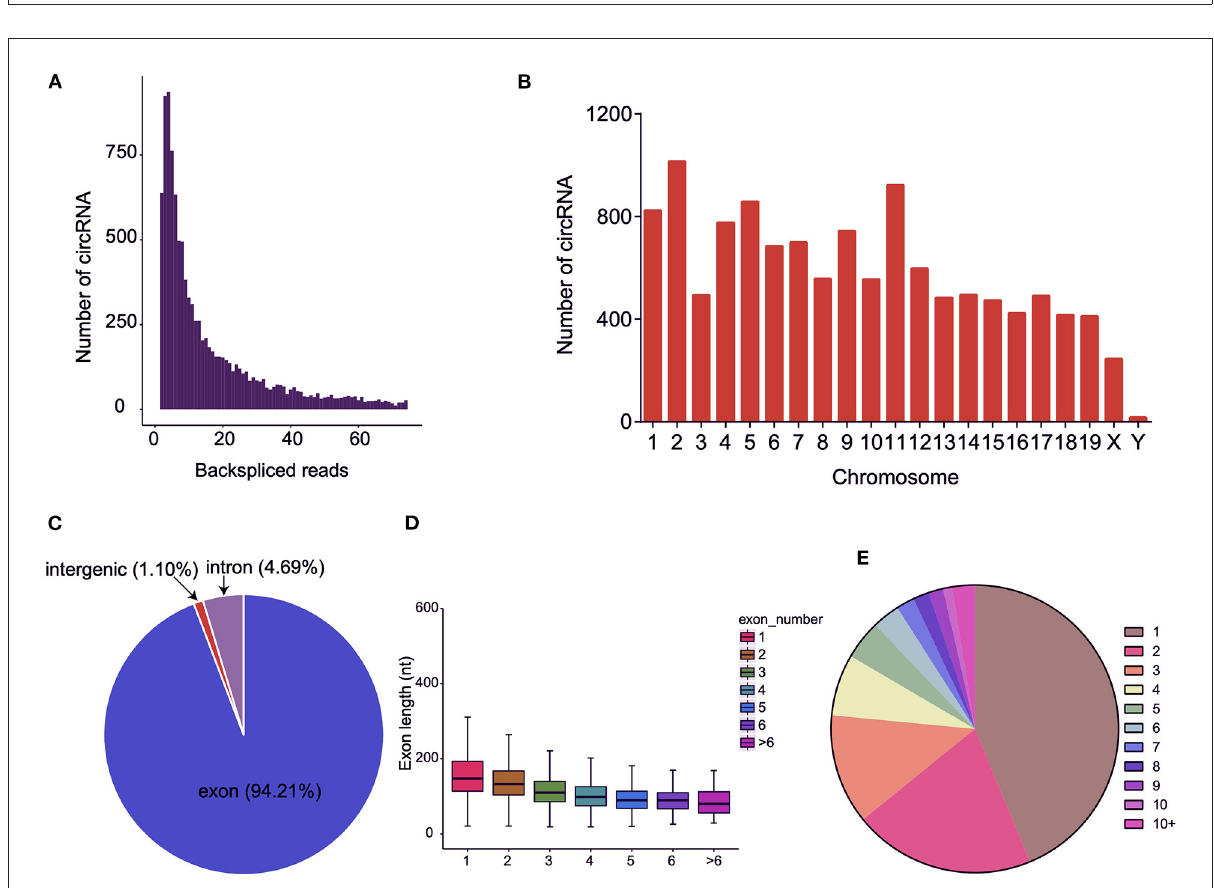
FIGURE2 Characteristics of circular RNAs (circRNAs) in brown adipose tissue (BAT) and white adipose tissue (WAT). (A) The number of circRNAs and back-spliced reads identified in three BAT and WAT samples. (B) Distribution of the identified circRNAs on different chromosomes. (C) Genomic origin of the identified circRNAs. (D) Distributions of exon length for the exon-derived circRNAs. (E) Number of circRNAs generated from a single